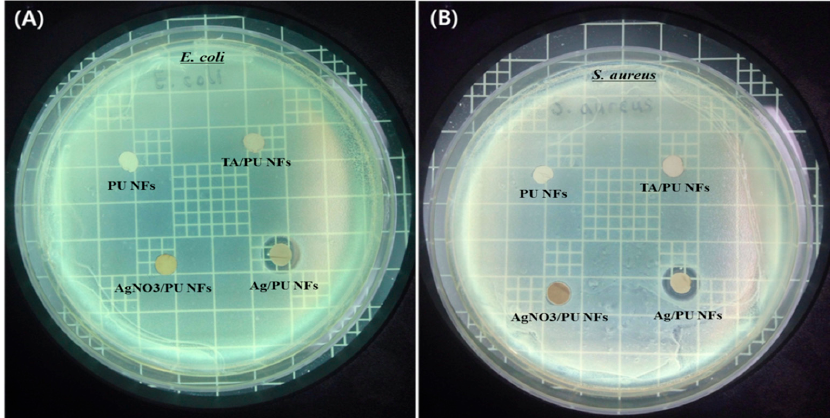
Figure 7. Zone of inhibition test showing the antibacterial performances of different samples against E. coli ( A ) and S. aureus ( B ).